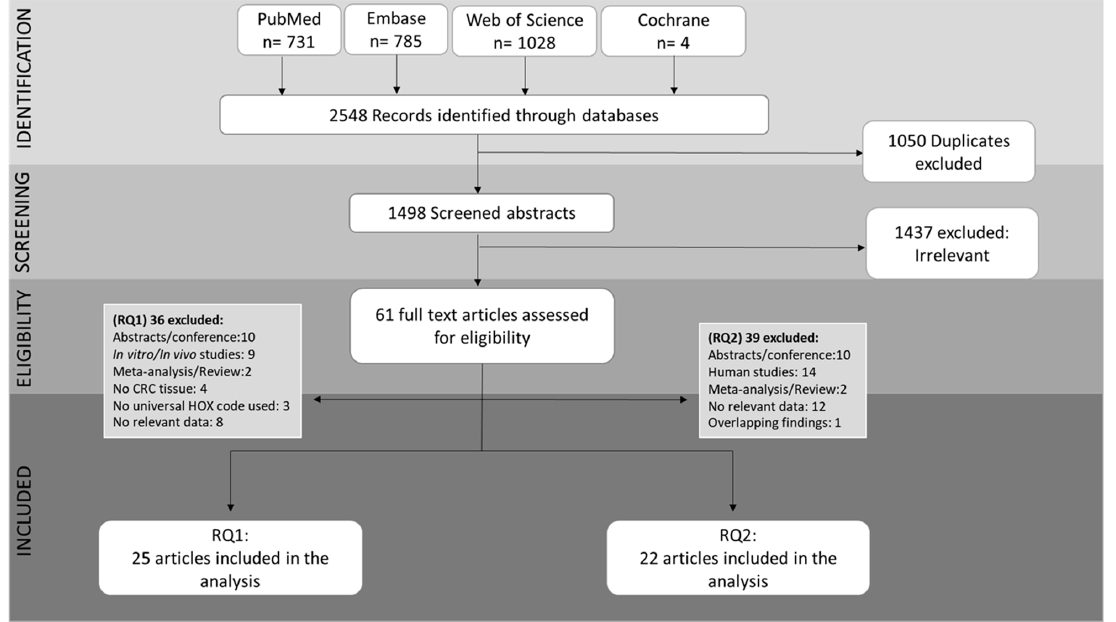
Figure 2. PRISMA flow chart of systematic review article retrieval (Microsoft PowerPoint software was used to create this figure).